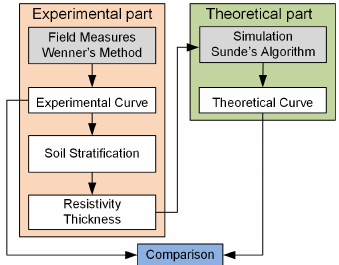
Figure 5. Data gathering and utilization of Sunde’s